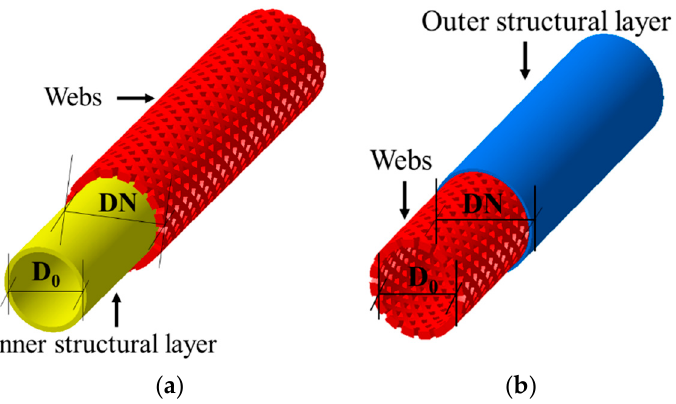
Figure 1. The overview of the proposed GFRP pipe: ( a ) Outer stiffened pipe; ( b ) inner stiffened pipe.